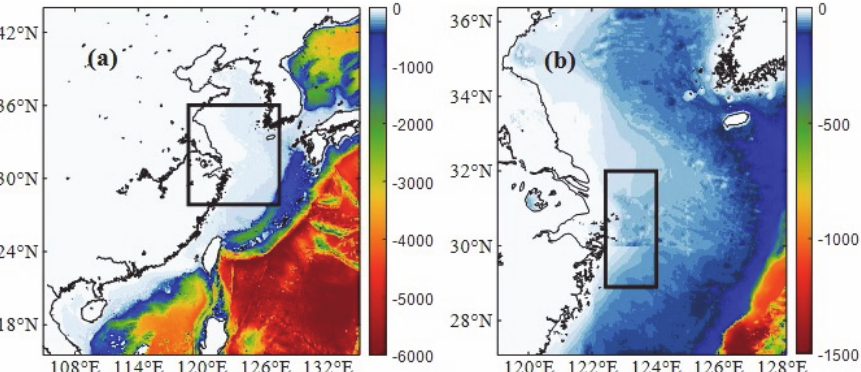
Figure 1. ( a ) The outer model domain covers the whole Chinese coastal region and part of western Pacific. The range of the black rectangle is the inner one (27° N–36° N, 119° E–128° E). ( b ) The inner model domain covers the Yangtze River estuary and part of East China Sea. The black rectangle (29° N–32° N, 122.5° E–124° E) is the area we analyzed.